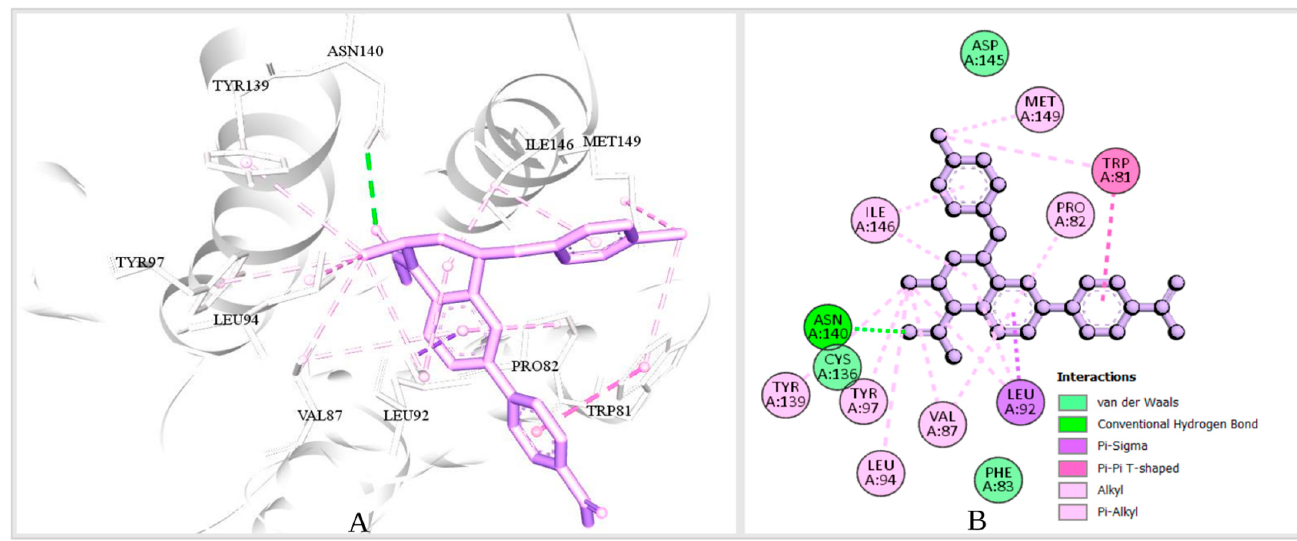
Figure 3. Binding sites of the protein. ( A ) The 3D representation of the binding-site residues of the protein retrieved from the PDB ID: 4BJX, and ( B ) the 2D representation of the binding-site residues of the protein-ligand interaction.